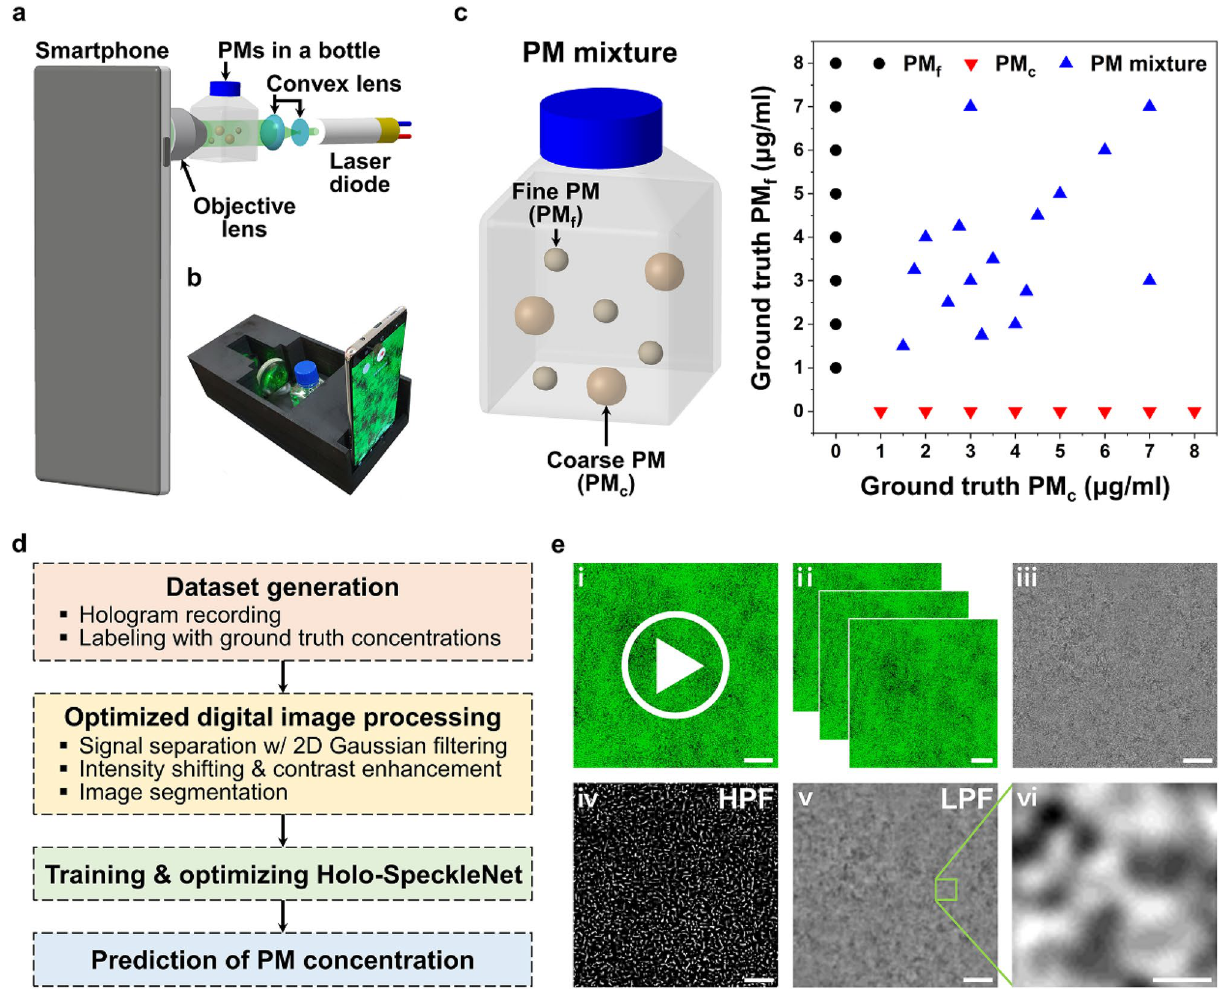
Figure 1. Smartphone-based device for monitoring suspended PMs in water. ( a ) Schematic of the experiment setup with optical arrangement. ( b ) Photograph of the S-DHM device. ( c ) Suspended PMs in a bottle. ( c ) PM test samples with various mass concentration ratios of PM f and PM c . ( d ) Overall procedure for predicting PM concentrations from holographic speckle images. ( e ) Digital image processing techniques used for preprocessing holographic speckle images. Scale bars: ( e i–v ) 25 μm; ( e vi ) 5 holograms (Fig. 1e ii ; .tiff). Each RGB hologram is cropped and converted into grayscale (Fig. 1e iii ; .tiff; 700 × 700). In each hologram, background noises are commonly formed due to unintended external vibrations and dust particles attached on optical components. A background image is obtained by ensemble averaging of consecutive holographic images. Then, the signal-to-noise ratio (SNR) of the holographic speckle patterns of test samples is enhanced by subtracting spatially invariant background noises. The holographic speckle patterns of polydisperse PM samples are composed of speckle signals of PM c and PM f . Each speckle signal in a recorded hologram can be separated by the difference in their spatial frequencies. First, a 2D fast Fourier transform (2D FFT) is used to convert a hologram from the spatial domain to frequency domain. 2D Gaussian pass filter is then adopted to eliminate the high or low spatial frequency components in the frequency domain. The Gaussian low-pass filter (LPF) and high-pass filter (HPF) are defined as follows: